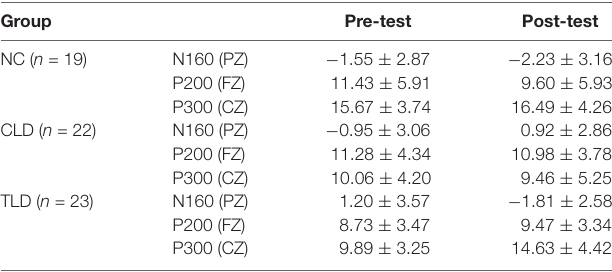
TABLE 4 | The values of N160, P200 and P300 ( µ V) of each group in pre- and post-test training. Group Pre-test Post-test